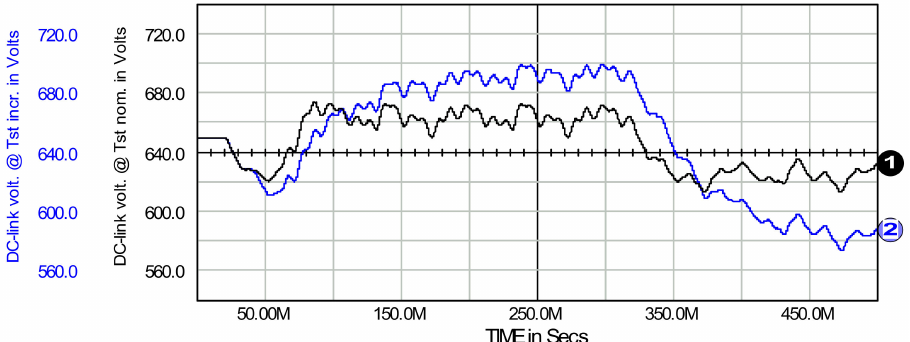
Figure 16. DC-link capacitor voltage at nominal magnitude of T st : waveform 1, and then at triple increased T st magnitude: waveform